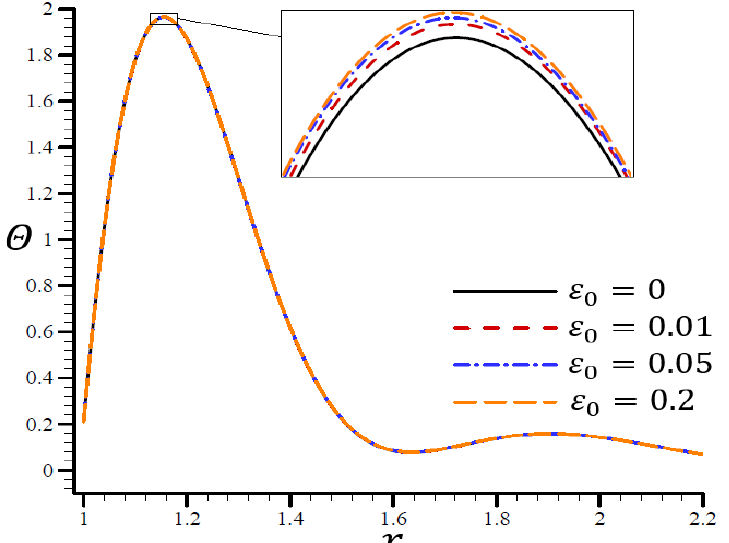
Figure 17. The influence of 𝜀 0 on temperature 𝛩 through the radial direction of a spherical hole using the RTPL model.